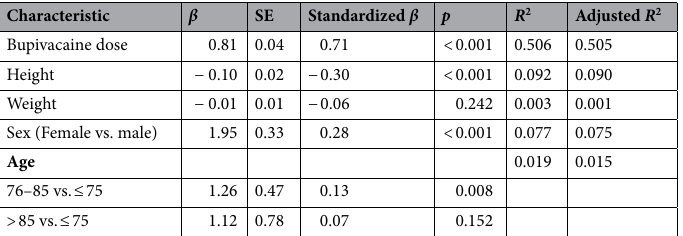
Characteristic β SE Standardized β p